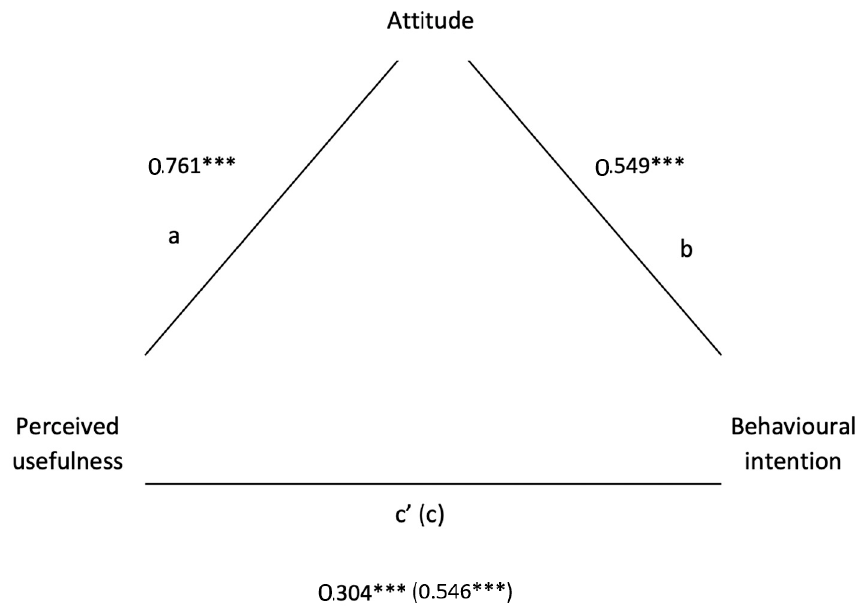
Figure 3. Mediation diagram (perceived usefulness ⇒ attitude ⇒ behavioural intention). Note. *** p < 0.001; a = effect of Perceived usefulness on Attitude, b = effect of Attitude on Behavioural intention, c = total effect, c’ = direct